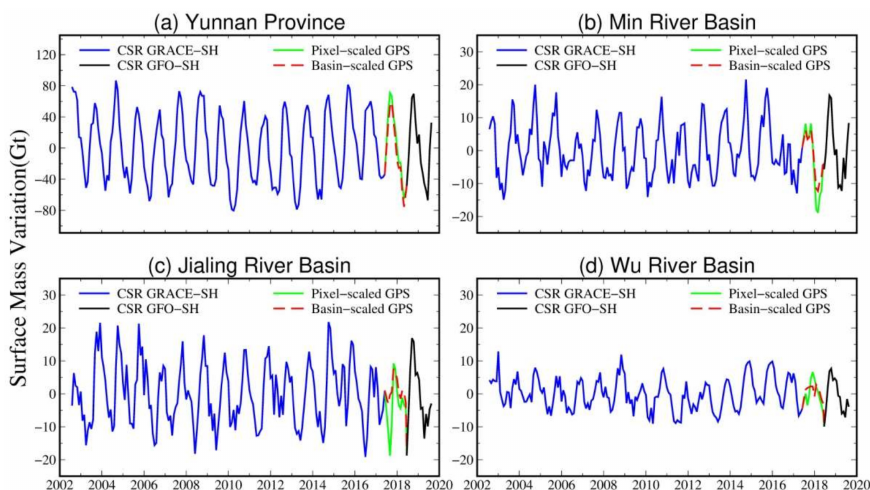
Figure10. Thelong-termsurfacemasschangetimeseriesinvertedbyjointofGRACE / GFOandGPSfrom August 2002 to August 2019 for the ( a ) Yunnan Province (YNP), ( b ) Min River Basin (MRB), ( c ) Jialing River Basin (JLRB), and ( d ) Wu River Basin (WRB), respectively. The joint inversion results include the mass change time series derived from CSR RL06 GRACE SH solutions (CSR GRACE-SH, from August 2002 to June 2017), CSR RL06 GFO SH solutions (CSR GFO-SH, from June 2018 to August 2019), and the mission gap is filled with scaled GPS-derived mass change time series (Basin-scaled GPS and Pixel-scaled GPS, from July 2017 to May